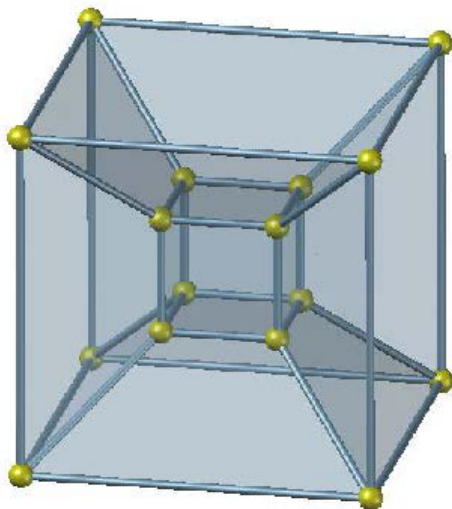
Figure 64: The 8 cubical cells of the tesseract folded, in threes, around the same